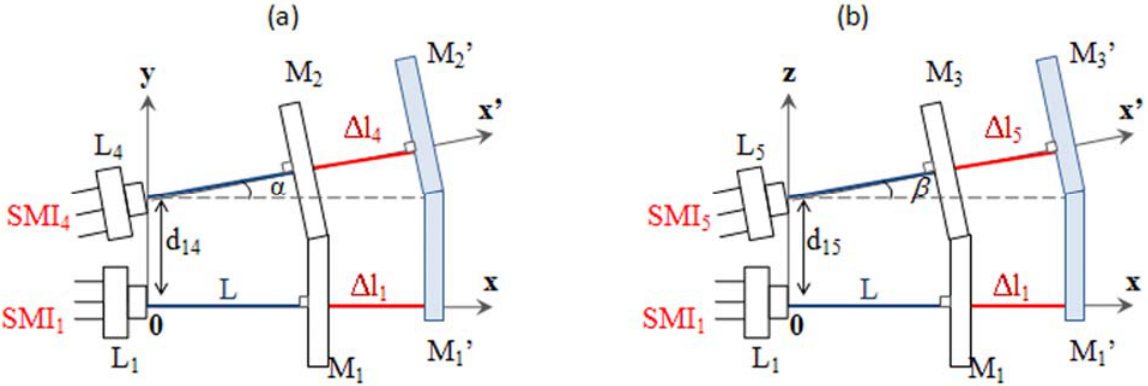
Figure 8. Schematic geometry of the setup for (a) straightness and (b) flatness measurement. Each interferometer SMI mirror M as target. M’ is the position of the target after the